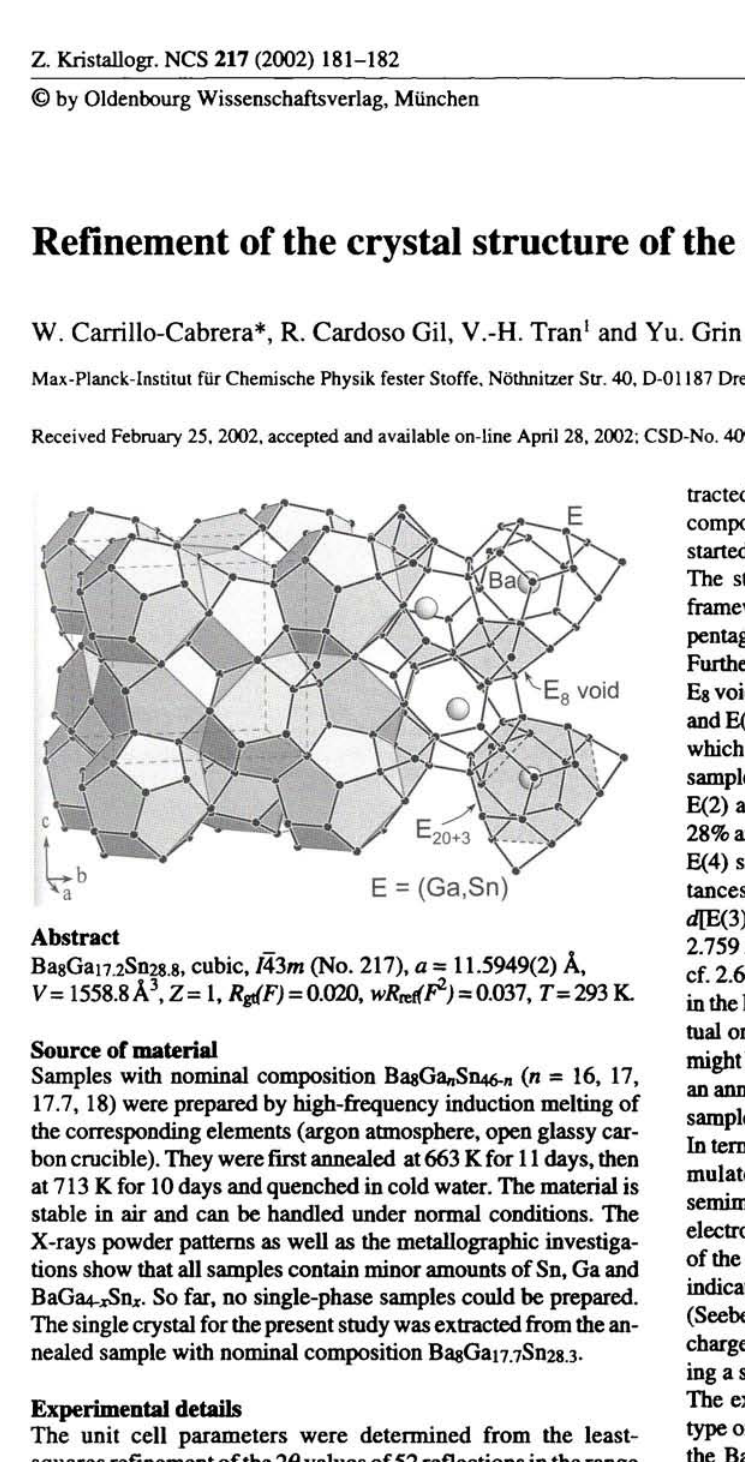
Table 1. Data collection and